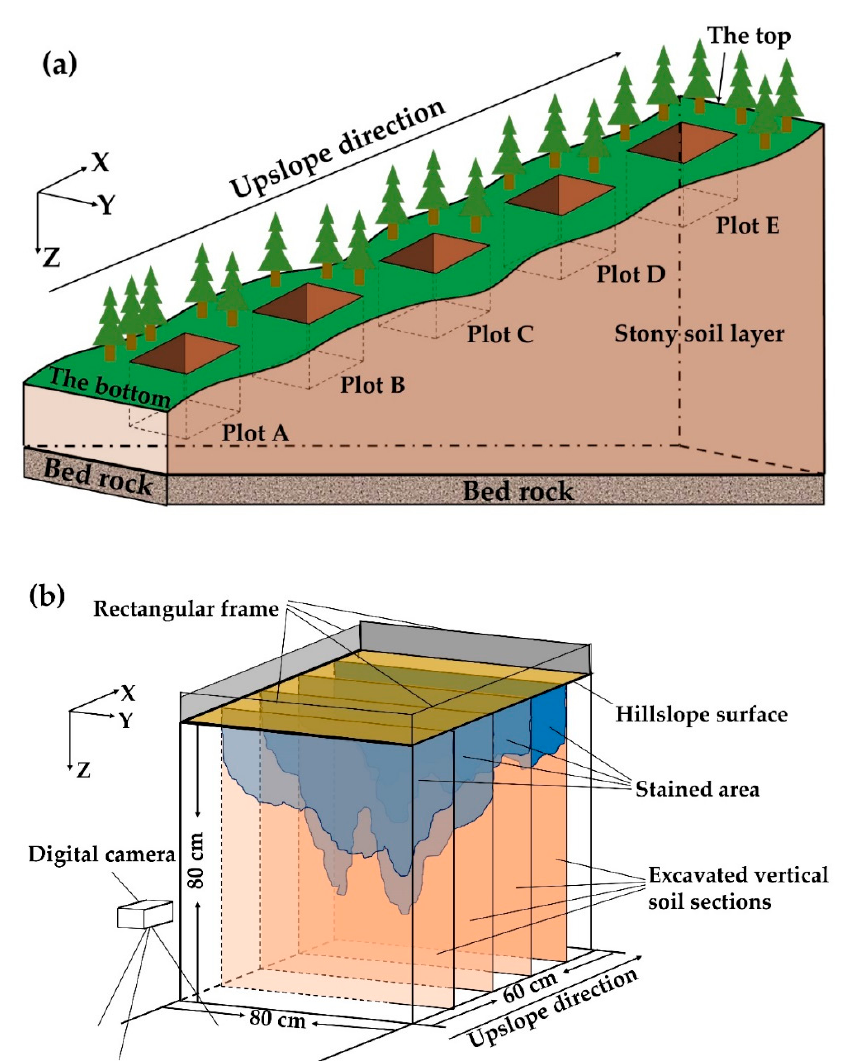
Figure 2. ( a ) Schematic of five experimental plots on the hillslope, and ( b ) excavation of vertical soil sections in a plot.